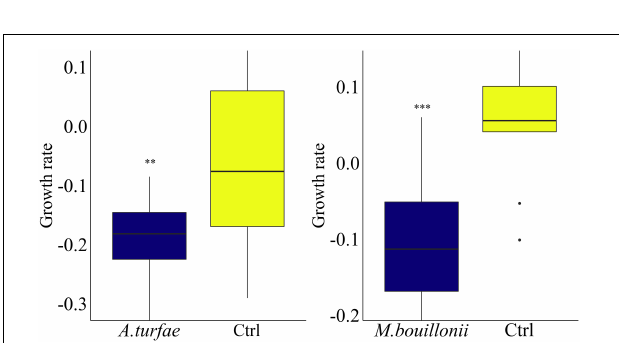
FIGURE 4 | Growth rates of Symbiodinium sp. incubated with cell-free filtrates with M. bouillonii (left) and A. turfae (right) . Whiskers: standard error. *Statistical significance compared to controls, p -value < 0.05. Asterisks represent significant p -values (alpha = 5%): p < 0.05 ∗ ; p < 0.01 ∗∗ ; p < 0.001 ∗∗∗